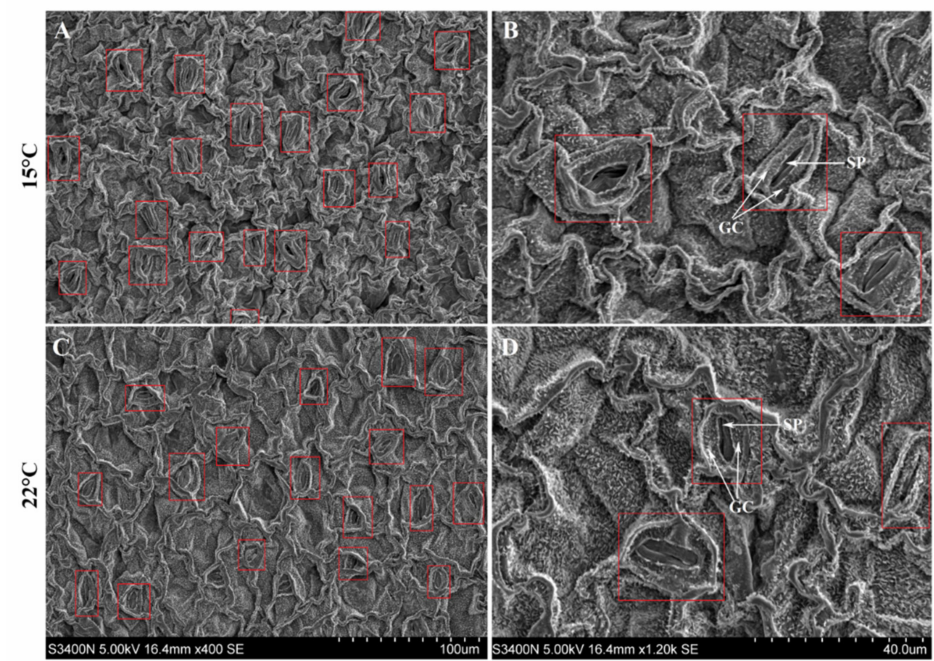
Figure 3. Stomata structure of H. perforatum seedlings grown at 15 and 22 ◦ C. GC, guard cell and SP, stomatal pore. Images ( A , B ) represent the scope 100 and 40 µ m at 15 ◦ C, images ( C , D ) represent the scope 100 and 40 µ m at 22 ◦ C, respectively. Table 1. Stomata characteristics of Hypericum perforatum seedlings grown at 15 and 22 ◦ C.